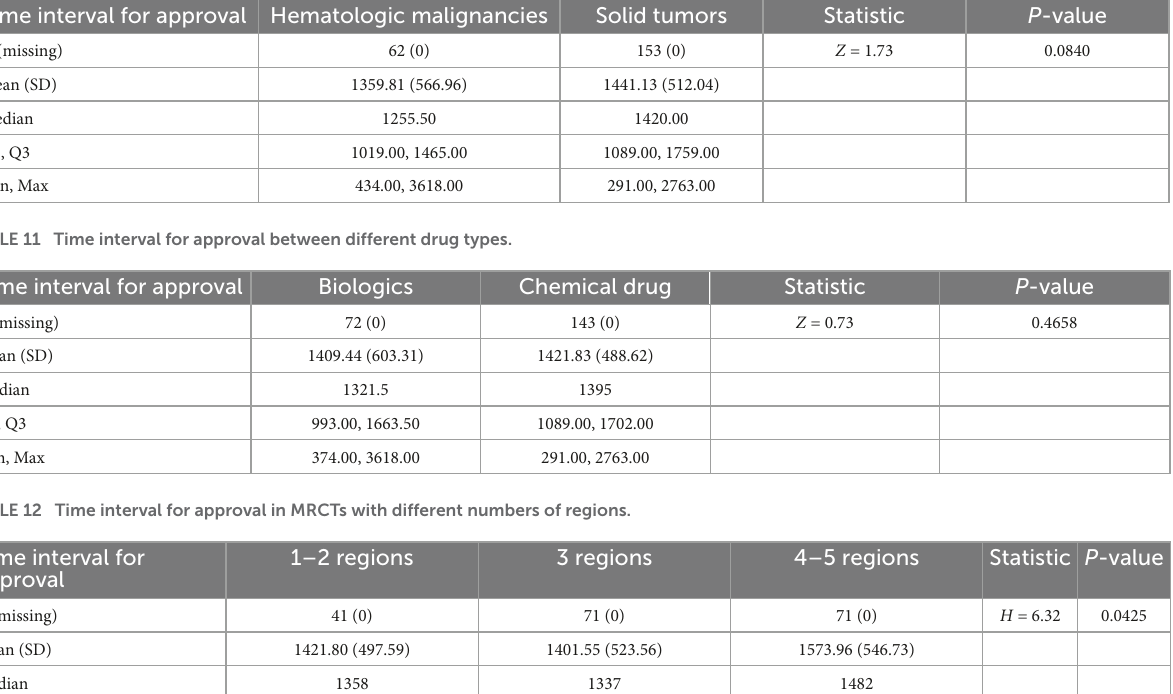
TABLE 10 Time interval for approval between different tumor types.